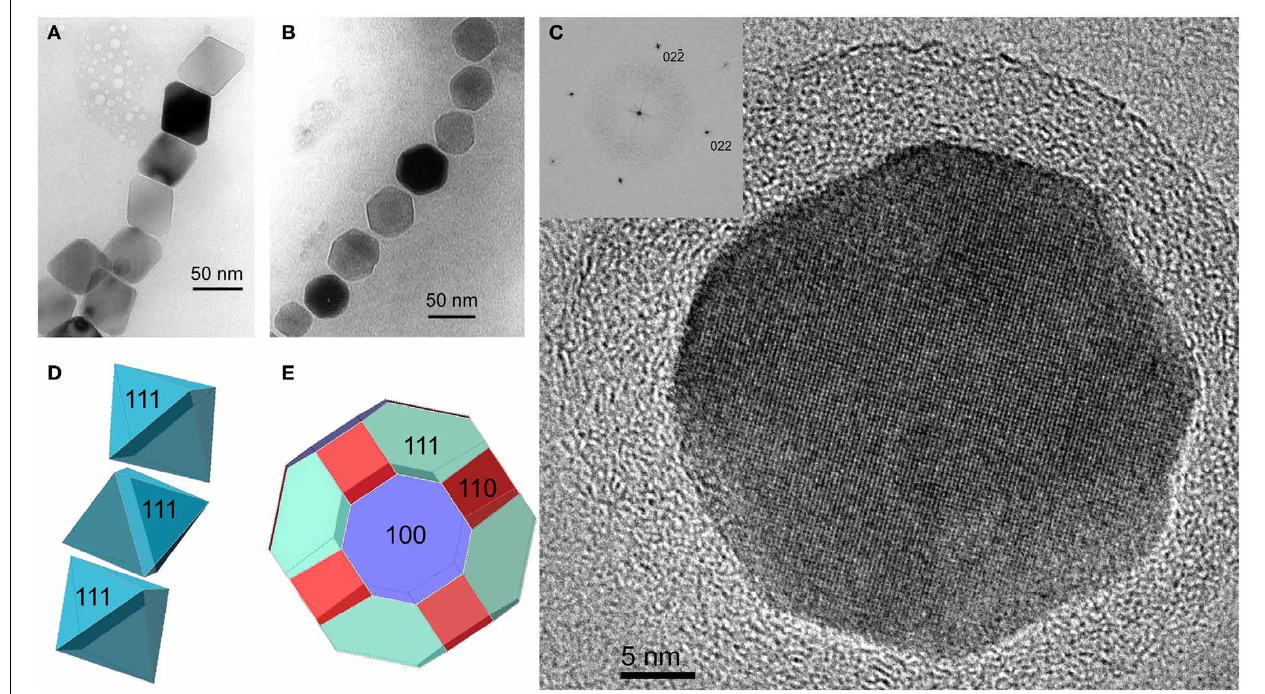
FIGURE 1 | Magnetite magnetosomes with octahedral and cuboctahedral morphologies. (A) Transmission electron microscope (TEM) image of a partial chain of relatively regular octahedra in an unidentified freshwater spirillum. (B) TEM image of a partial chain of cuboctahedral magnetosomes in a cell of an alphaproteobacterial Magnetospirillum species isolated from Lake Ely, Pennsylvania. (C) High-resolution TEM image of a cuboctahedral magnetosome from the magnetotactic alphaproteobacterium